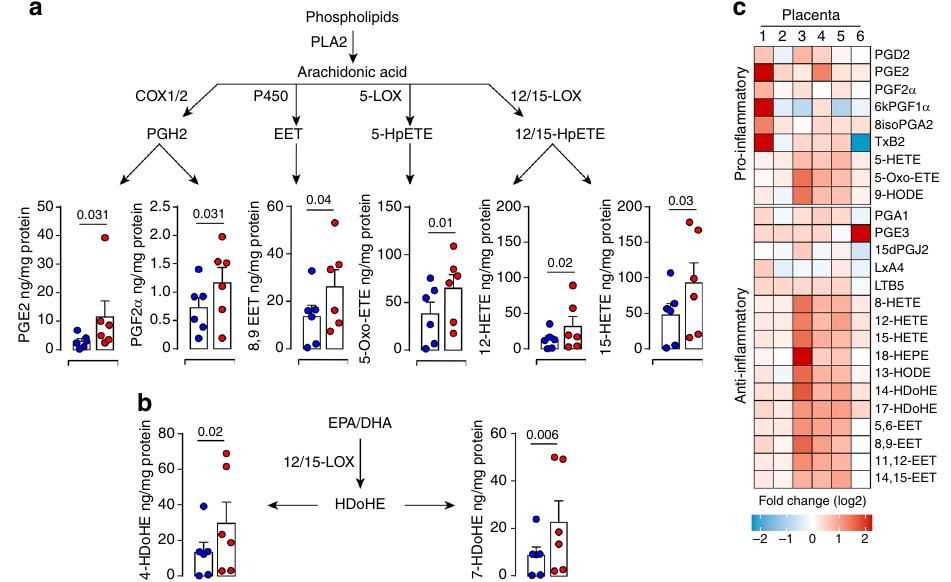
Fig. 9 ZIKV-induced in fl ammatory response contributes to placental dysfunction. Bioactive lipids are extracted from mock- and 5 dpi ZIKV-infected placentas and analyzed by LC-MS/MS. Absolute quanti fi cation of selected eicosanoids derived from PLs through the phospholipase A2 (PLA2) was calculated based on the calibration curves of deuterated internal standards and normalized by the amount of protein in each sample. Quantities of lipids are presented as ng/mg of protein for each placenta sample. a Quanti fi cation of eicosanoids derived from the cyclooxygenase (COX), lipoxygenase (LOX), and cytochrome P450 (CYP450) pathways. b Quanti fi cation of eicosanoids derived from the EPA-DHA. c Heatmap representing fold change of lipid mediators segregated according to their role as pro-/anti-in fl ammatory. Each column represents individual placentas from six independent donors (1 – 6). Results are presented as mean values ± SEM. P values are computed using paired two-tailed Student ’ s t test. Source data are provided as a Source Data fi